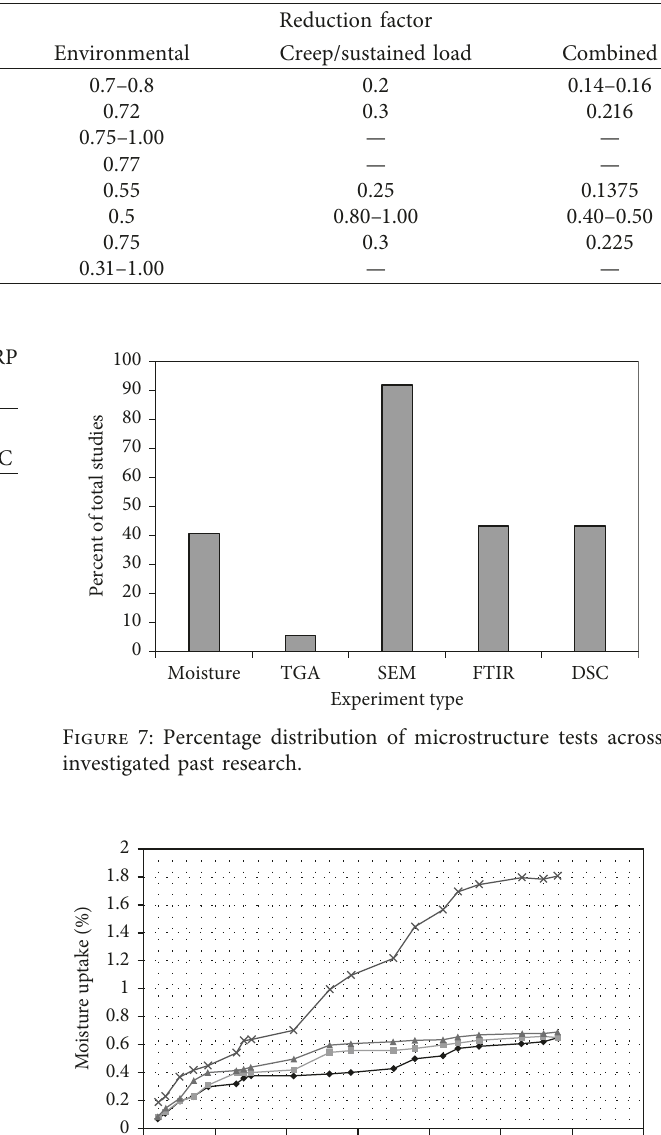
Table 6: Summary of reduction factors for GFRP reinforcing bars.